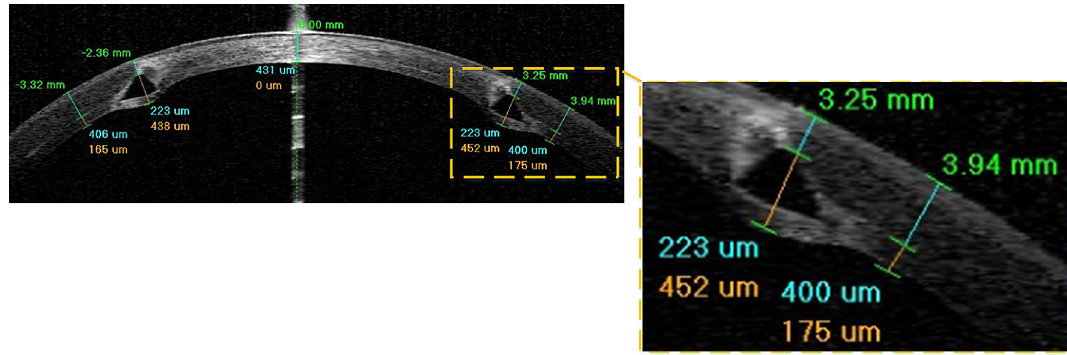
Figure 10. The postoperative AS-OCT image of ICRS implementation surgery (case